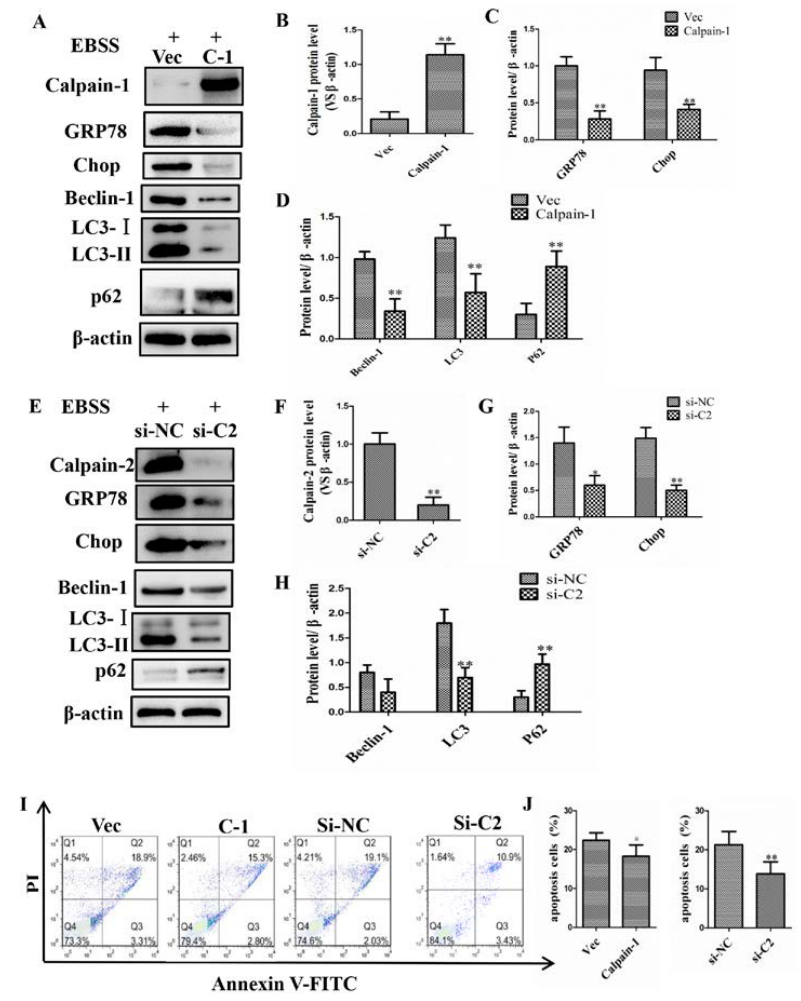
Figure 5. Calpain-1 and calpain-2 modulate ER stress, autophagy and apoptosis in ARPE-19 cells. ( A – D ) The activations of ER stress, autophagy and apoptosis were inhibited by calpain-1 plasmid transfection; ( E – H ) The activations of ER stress, autophagy and apoptosis were suppressed by siRNA knockdown of calpain-2 . ( I , J ) The apoptosis rate of ARPE-19 cells was evaluated by a flow cytometer. * p < 0.05, ** p < 0.01, compared with EBSS group, (C1 = calpain-1, C2 =